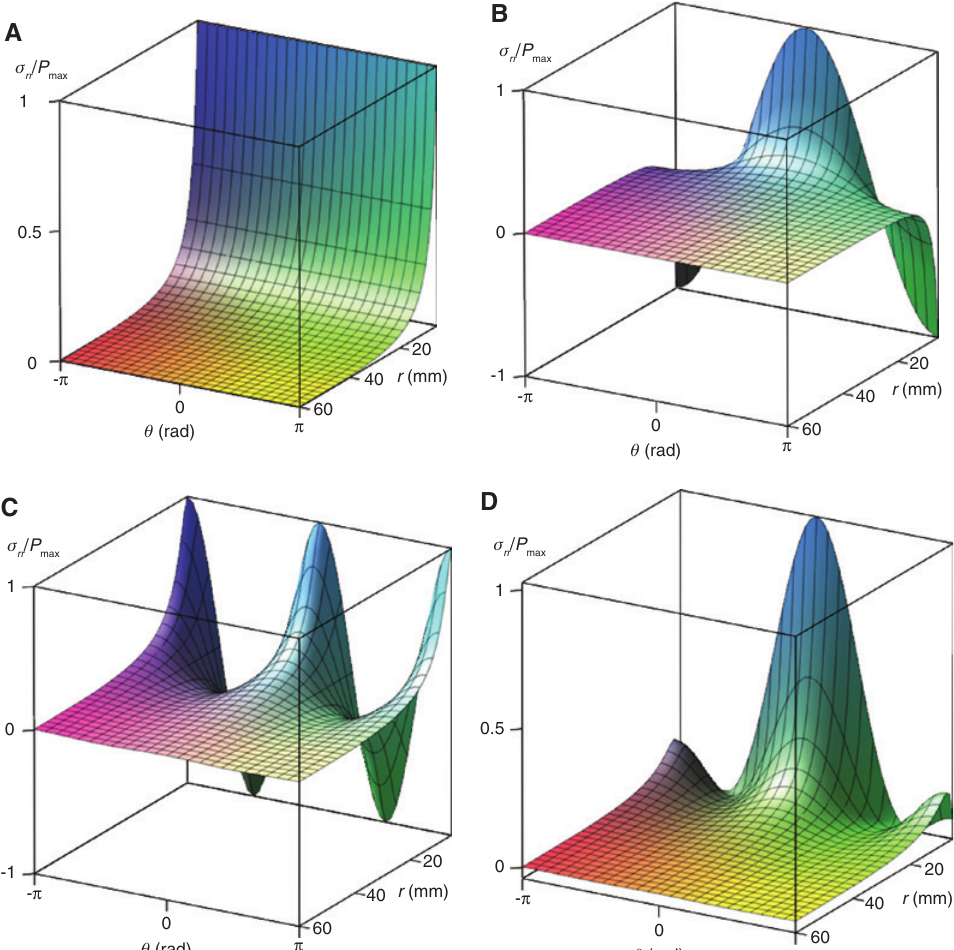
Figure 9: The near-field non-dimensional radial stresses of the joint with FGM inter-layer ( n = -1): (A) λ = 0, (B) λ = 1, (C) λ = 2, and (D) weighted superposition of A, B, and